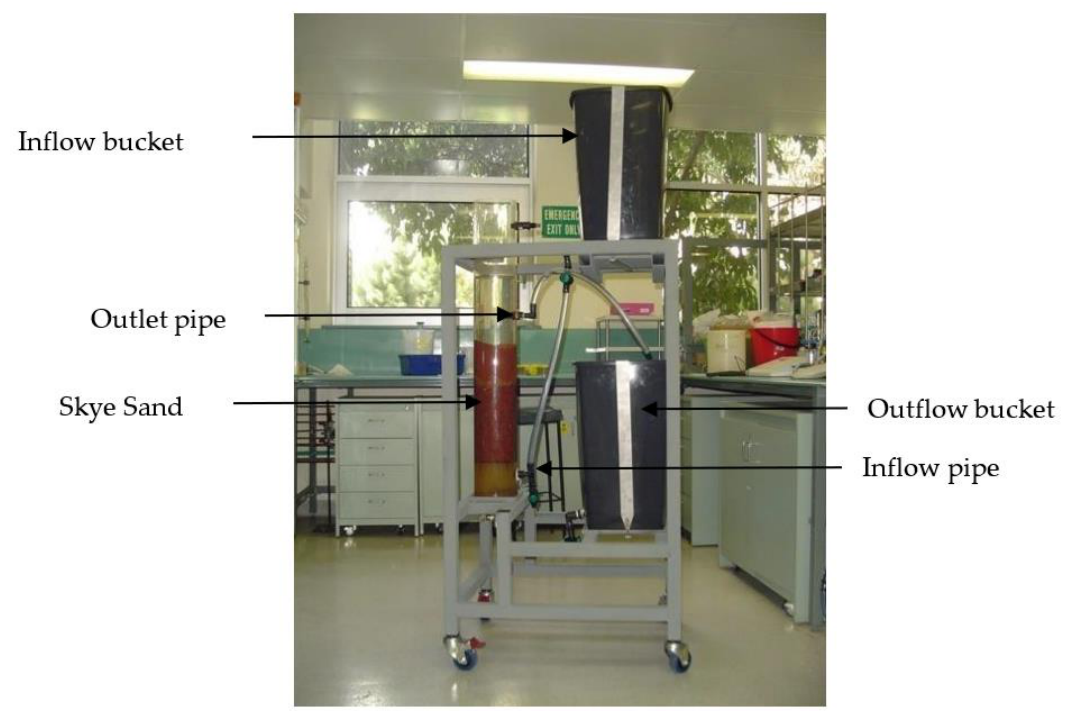
Figure 3. The prototype filter in the laboratory.